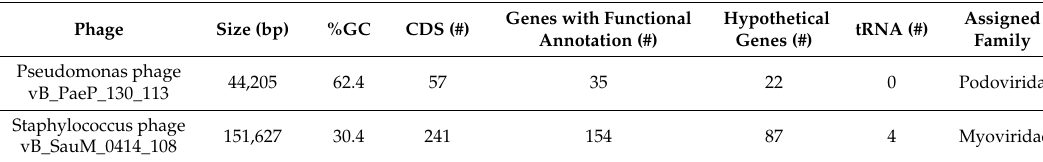
Table 5. Finished genome